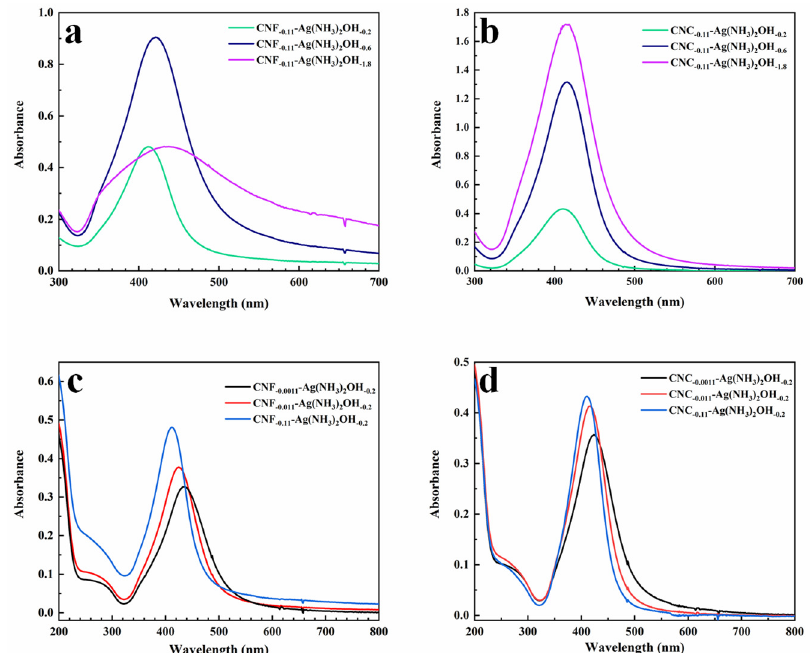
Figure 7. UV-Vis spectra of NC-AgNPs after 2.5 h reaction. UV-Vis spectra of AgNPs mixed system (( a ), CNF-AgNPs; ( b ), CNC-AgNPs) obtained at different concentrations of silver ammonia solution (the concentration of nanocellulose is 0.11 mg/mL, the concentration of glucose is 45 μ M); UV-Vis spectra of AgNPs mixed system (( c ), CNF-AgNPs; ( d ), CNC-AgNPs) obtained at different nanocellulose concentrations (the concentration of silver ammonia solution is 0.2 M, the concentration of glucose is 45 μ M) .